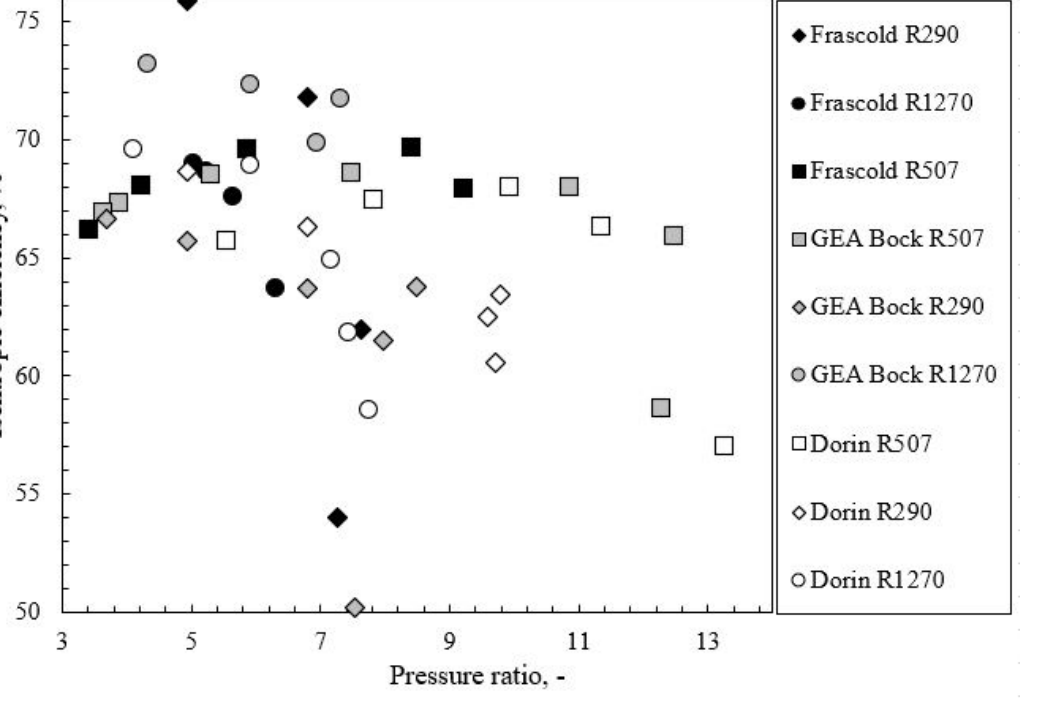
Figure 5. Isentropic efficiency with respect to the pressure ratio of semi-hermetic refrigeration com- pressors estimated using the dedicated selection software provided by the manufacturers